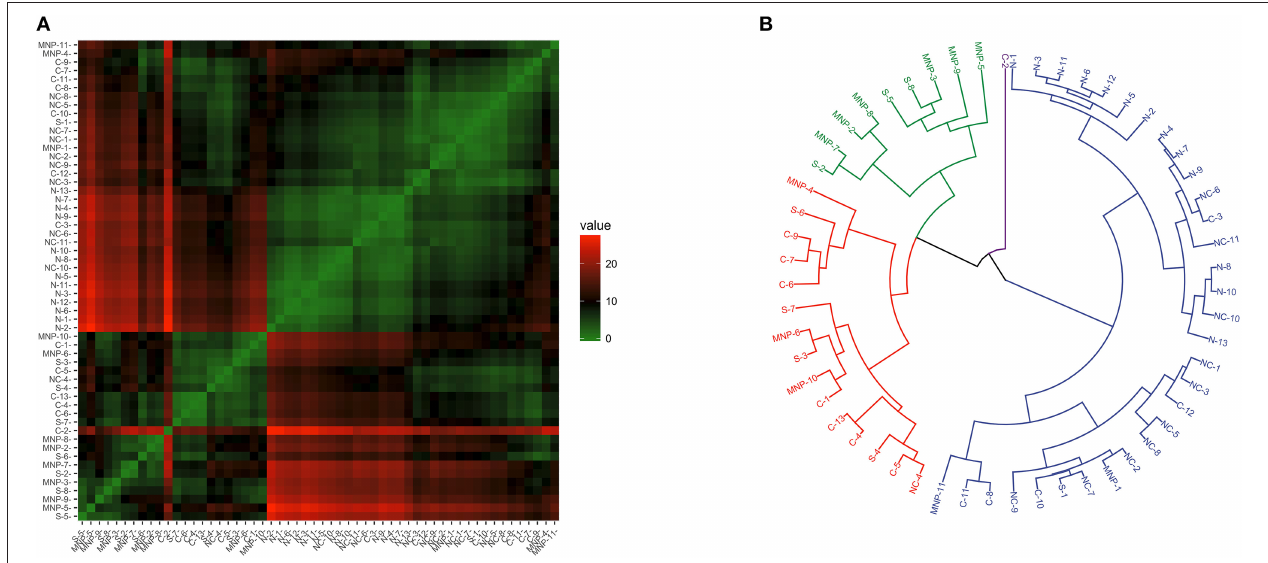
FIGURE 4 | Similarity of Th2 and immunomodulation ( GATA3 and FoxP3 gene expression) in blood of California sea lions. (A) Heatmap shows similarity clustering of the gene profiles. Green indicates low dissimilarity and red indicates high dissimilarity in relative transcription levels of the six genes. (B) Dendrogram of gene transcription profile clustering. The tree was built using an Euclidean algorithm. S, South; C, Central; NC, North-Central (Midriff); N, North; MNP, Mexican North Pacific.